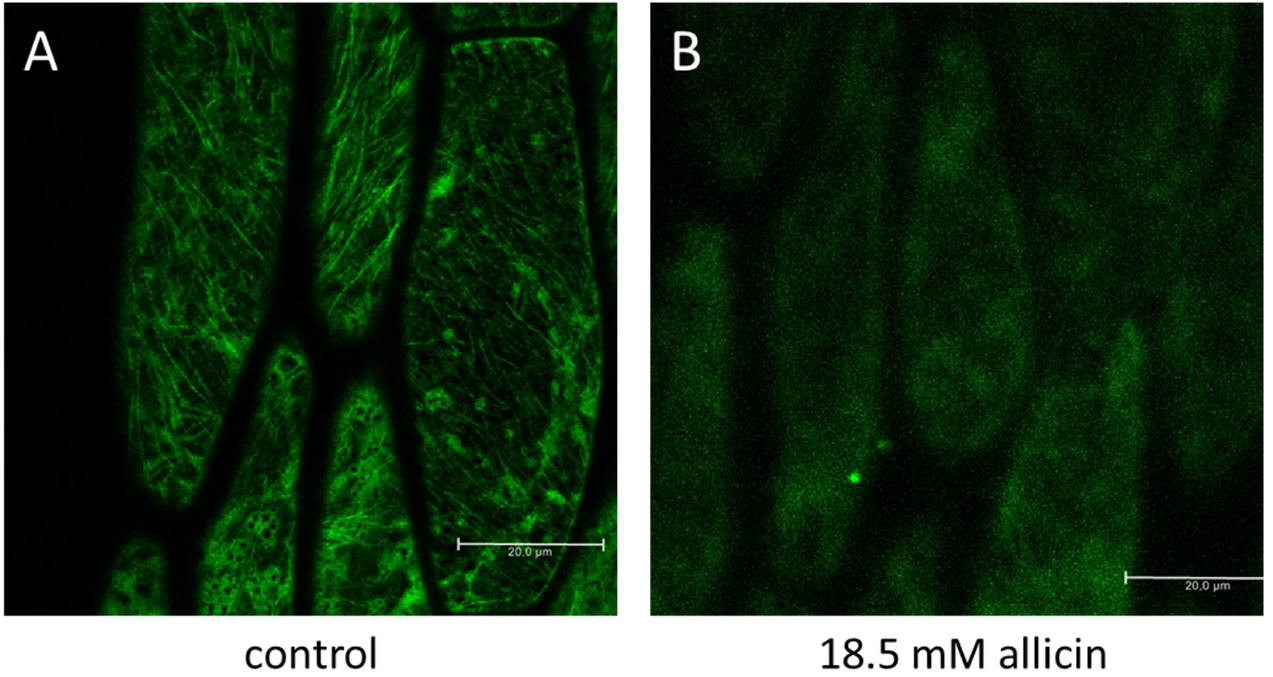
Figure 2. The influence of allicin on the organization of tubulin. Three-day-old Arabidopsis seedlings expressing GFP-tagged tubulin were incubated for 10 min in 18.5 mM allicin and subsequently viewed with a confocal laser scanning microscope (Leica, Wetzlar, Germany). While the tubulin filament structure is clearly visible in the water control ( A ) it takes on a more amorphous appearance after treatment with allicin ( B ). The scale bar = 20 μ m.